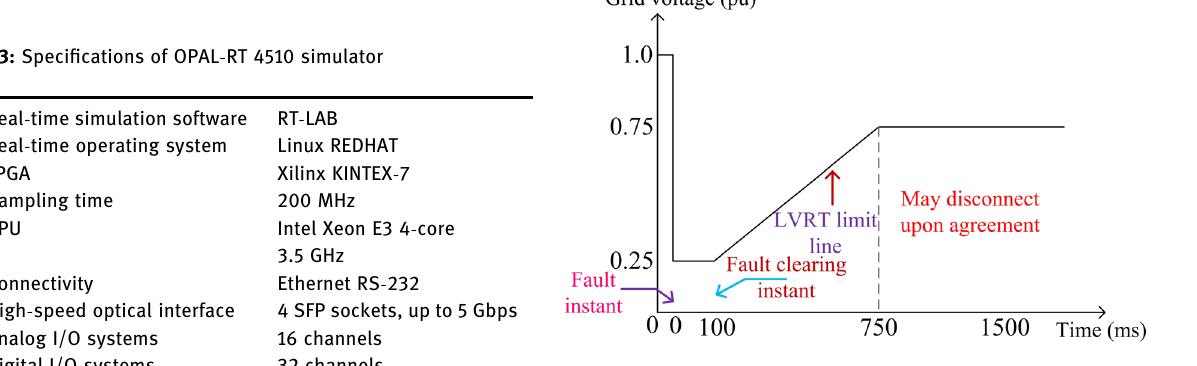
Figure 9: Danish grid